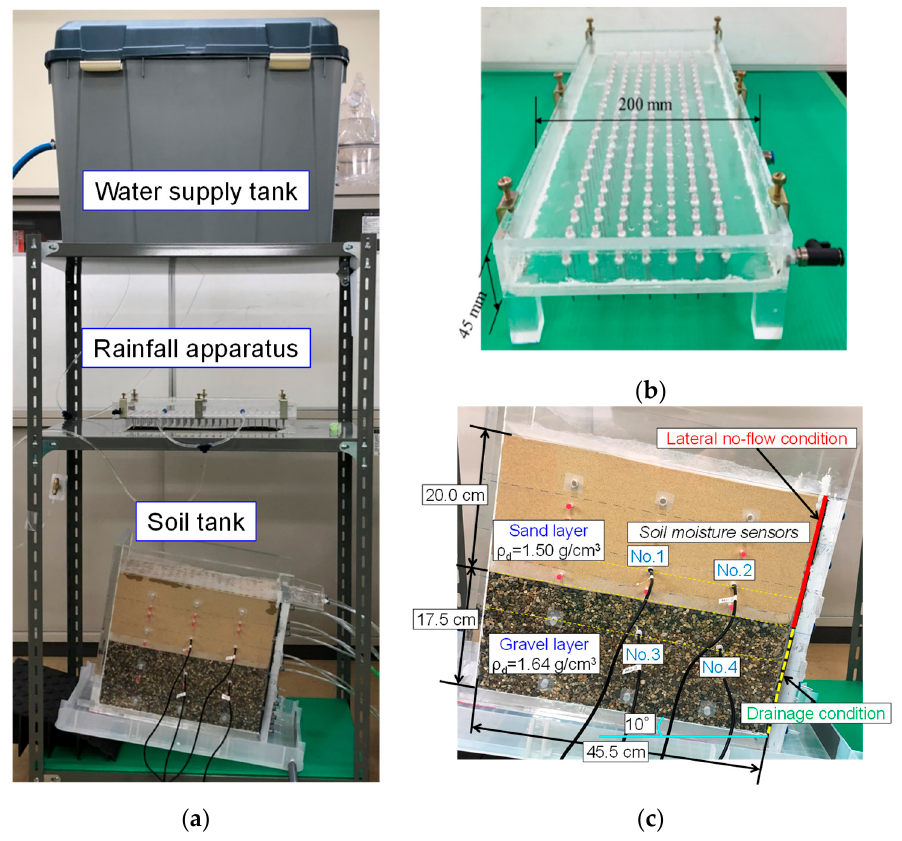
Figure 4. Apparatus and conditions of the laboratory SSCB model test under the lateral no-flow condition: ( a ) apparatus of the SSCB model test; ( b ) rainfall apparatus; ( c ) setting conditions. Table 3. Conditions of the SSCB model test.